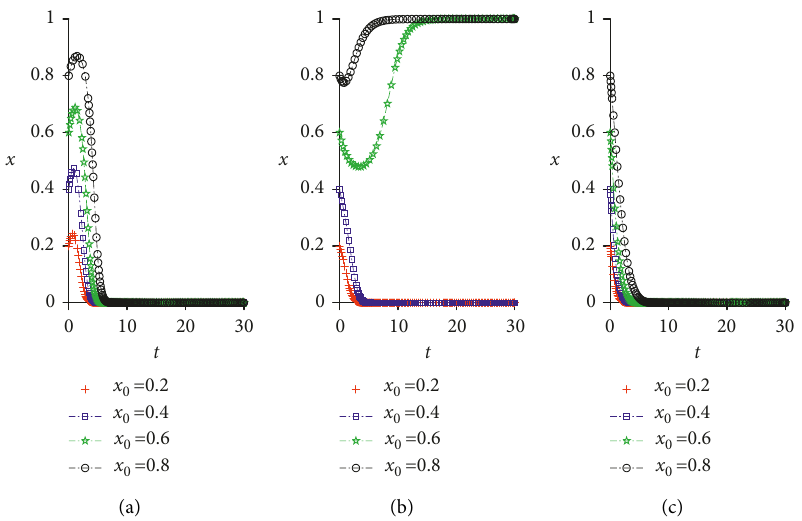
Figure 13: Impact of θ on system evolution. According to (b), when the cost sharing proportions of the two parties are equal, the system may evolve to the ideal state or the worst state, while according to (a) and (c), when one party’s cost sharing proportion is much smaller than that of the other party, the system will evolve to the worst state. (a) θ